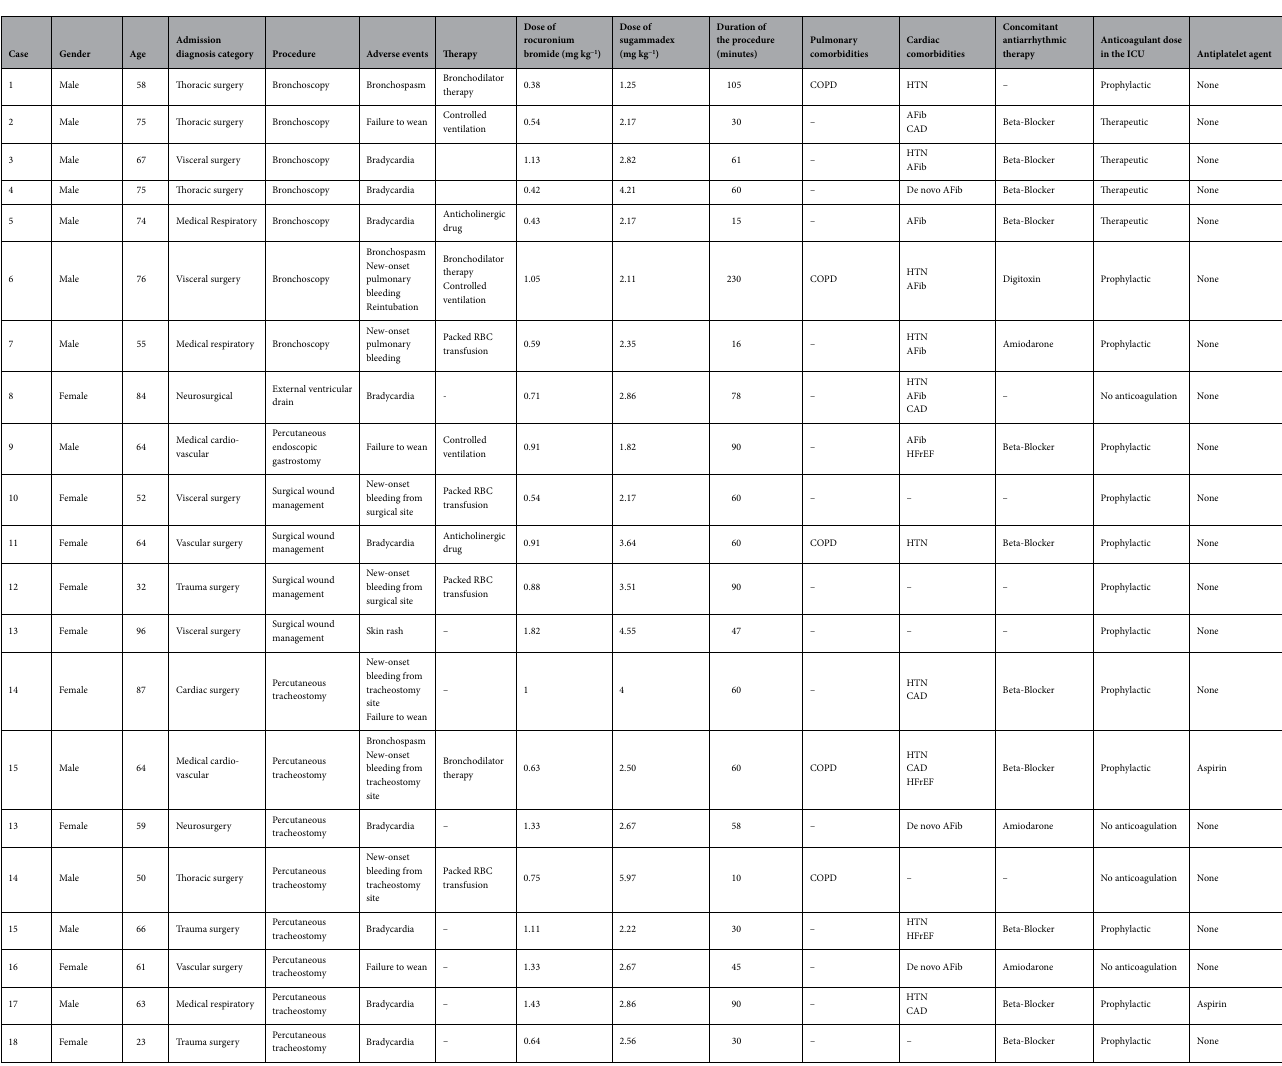
Table 3. Overview of the patients who experienced adverse events after sugammadex. COPD chronic obstructive pulmonary disease, HTN arterial hypertension, AFib atrial fibrillation, CAD coronary artery disease, RBC red blood cells, HFrEF heart failure with reduced ejection